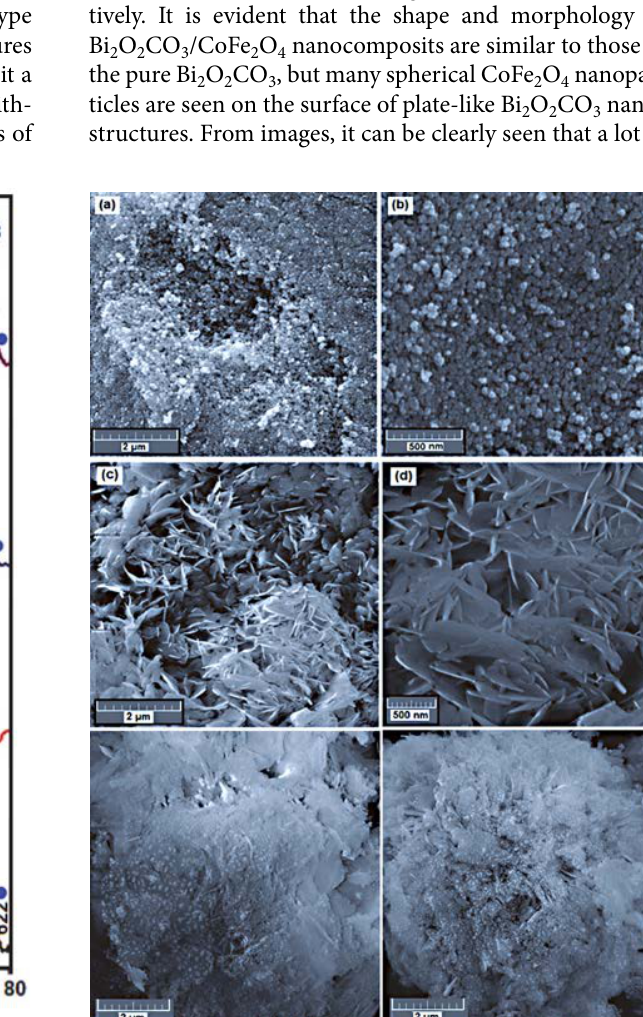
Figure 3. SEM images of (a and b) CoFe 2 O 4 , (c and d) Bi 2 O 2 CO 3 , (e)